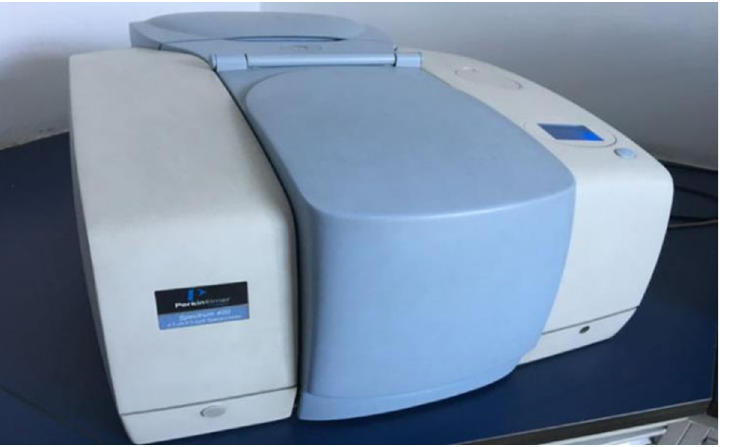
Fig 4. The diagram of the infrared spectrum test process.